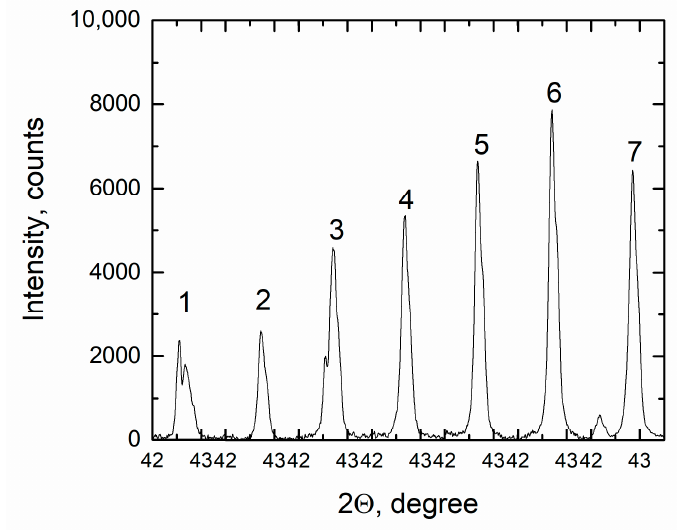
Figure 11. Intensity of the reflection orthorhombic phase for (1) FLiNaK + 0.5 mol.% NdF 3 ; (2) FLiNaK + 1.0 mol.% NdF 3 ; (3) FLiNaK + 2.0 mol.% NdF 3 ; (4) FLiNaK + 3.0 mol.% NdF 3 ; (5) FLiNaK + 4.0 mol.% NdF 3 ; (6) FLiNaK + 5.0 mol.% NdF 3 ; (7) FLiNaK + 7.5 mol.% NdF 3